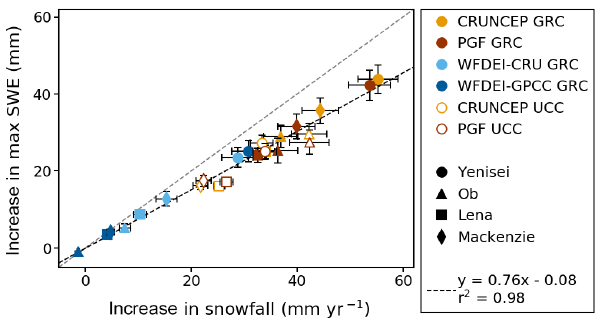
Figure 8. Increase in annual maximum SWE (mm) from CTL to GRC and UCC runs compared to an increase in annual snowfall (mmyr − 1 ), averaged over all basins (using the GlobSnow mountain mask for snowfall as well as SWE) for each driving data set. This is averaged over the whole of each JULES run (see Table